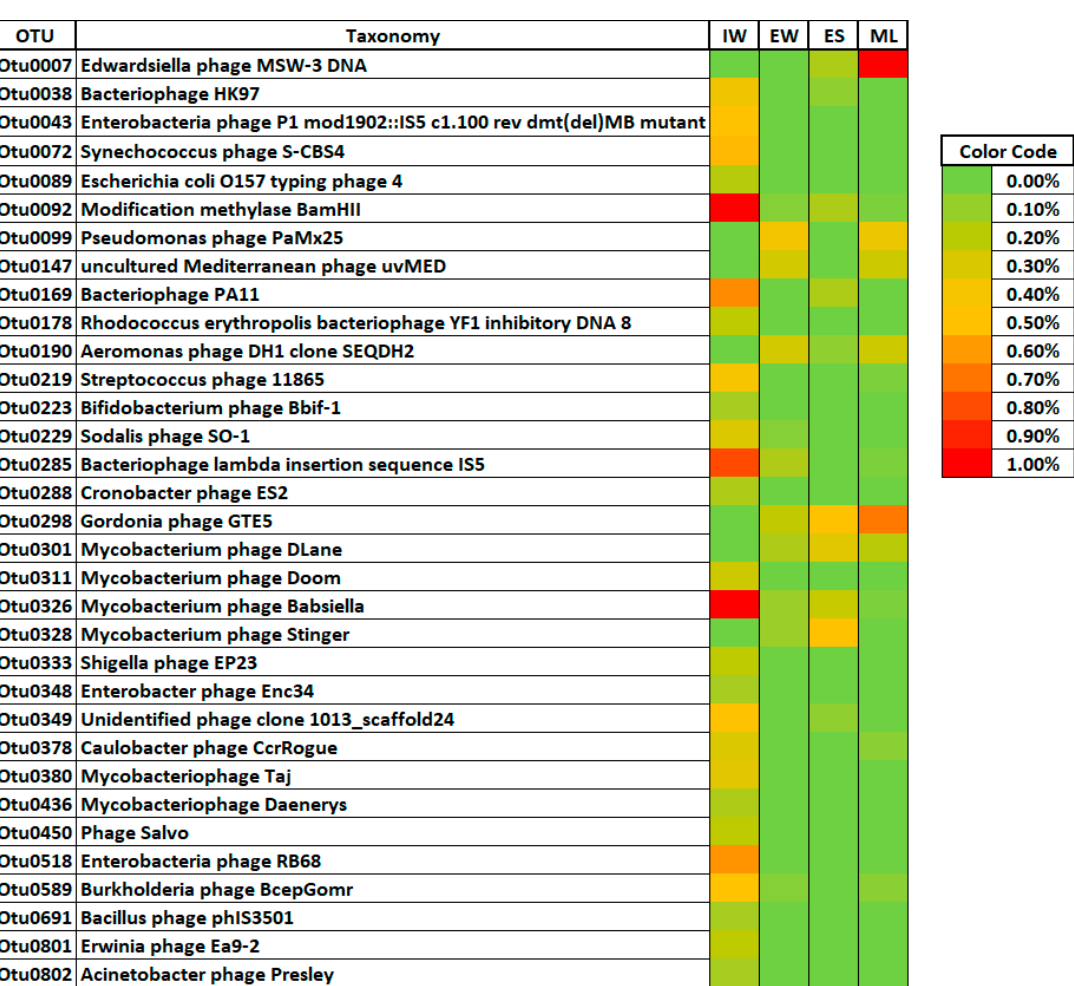
Figure 6. Sensitive viral phylotypes selected by expected effect size (EES) and differential expression analysis (DEA). analysis